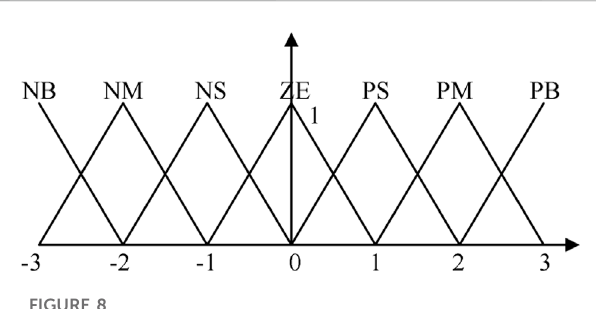
FIGURE 8 The membership function with input and output variables.